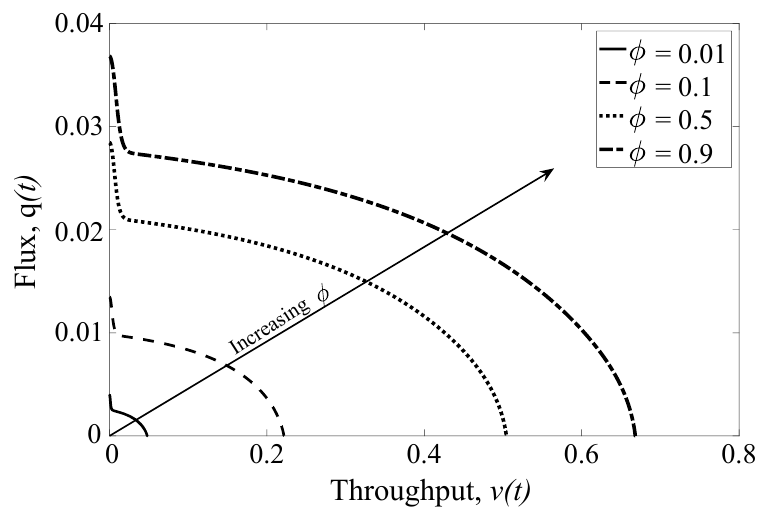
(cid:82) t q ( t (cid:48) ) dt (cid:48) , for several different values of 0